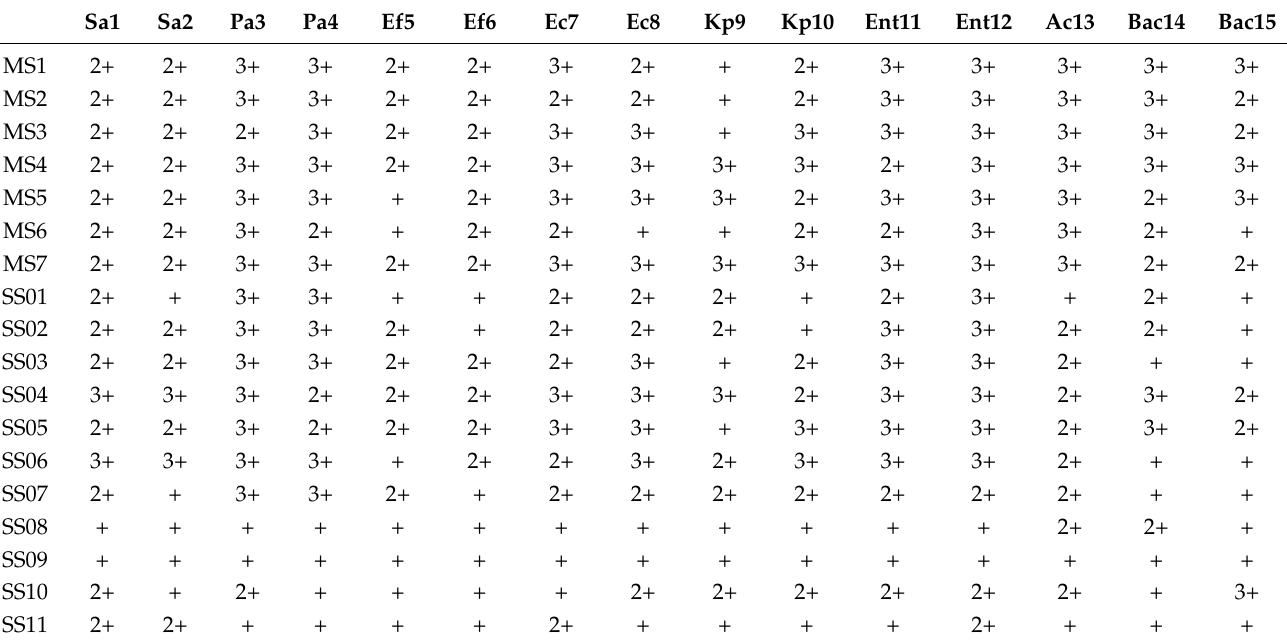
Table 9. Evaluation of the antagonistic effect of various probiotics and other beneficial microbes against clinical skin pathogens using the co-culturing